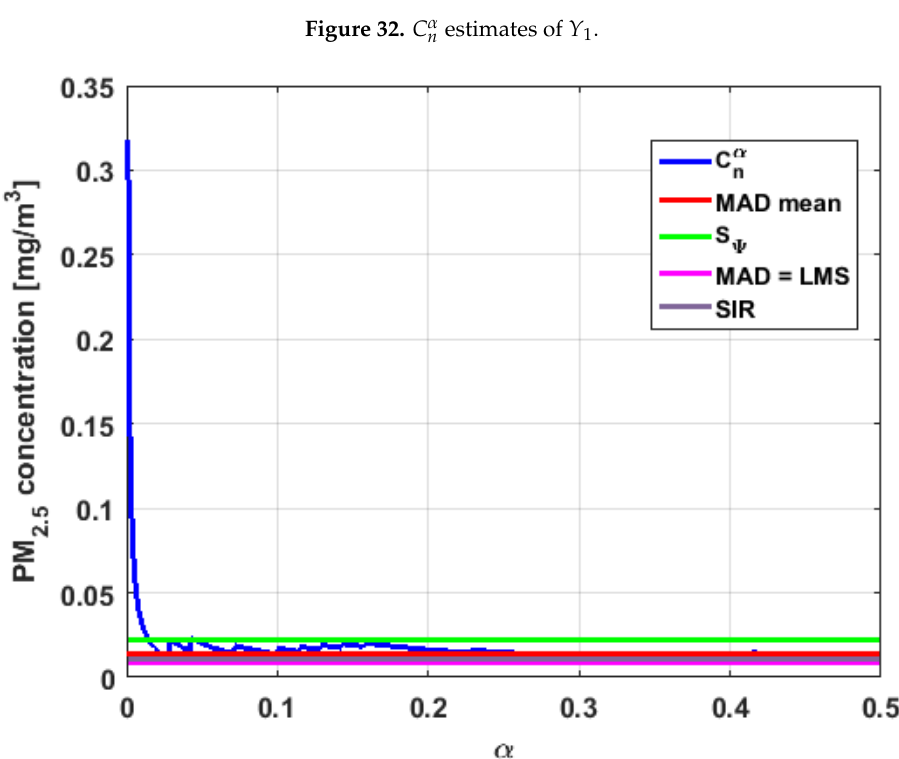
Figure 32. 𝐶 𝑛𝛼 estimates of 𝑌 1 . Figure 32. C α n estimates of Y 1 .